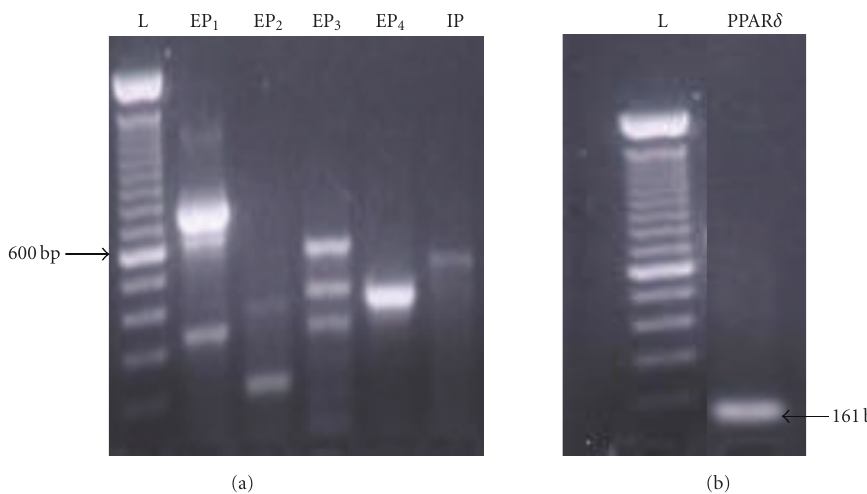
Figure 1: EP receptor subtypes and PPAR δ are expressed in IMCD-K2 cells. RNA was isolated from IMCD-K2 cells using TRIzol, reverse transcribed, amplified by polymerase chain reaction using primers for (a) the prostanoid receptors and (b) PPAR δ receptor, and visualized on an agarose gel using ethidium bromide under ultraviolet light. As shown, specific bands for each PCR product were obtained at the predicted size for EP 1 (336 base pair), EP 3 (437 base pair; plus bands at ∼ 350 base pair and ∼ 600 base pair), and EP 4 (423 base pair), as well as PPAR δ (161 base pair).